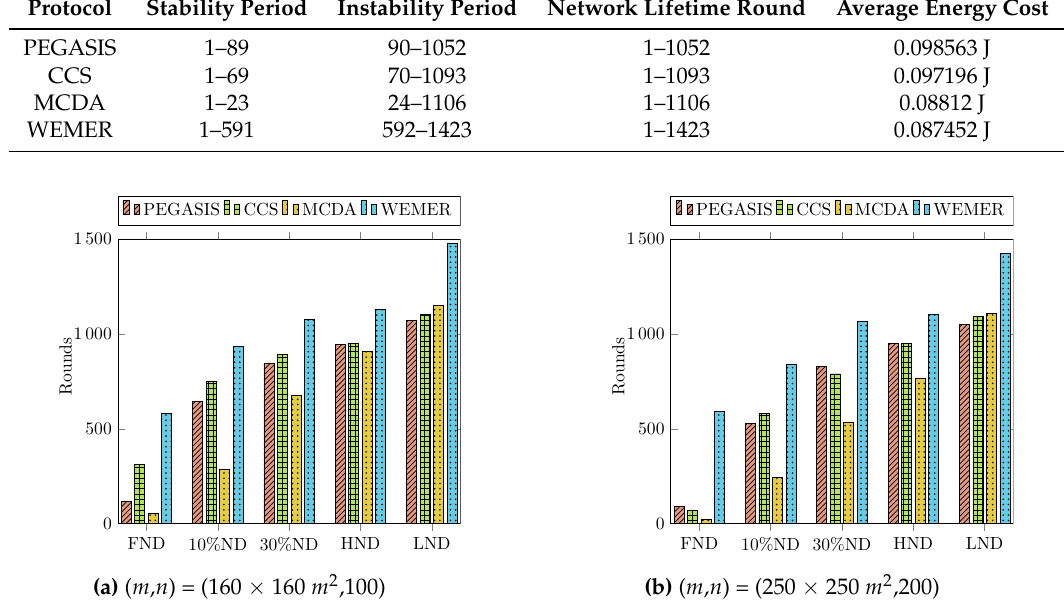
Figure 17. Percentage of dead node.